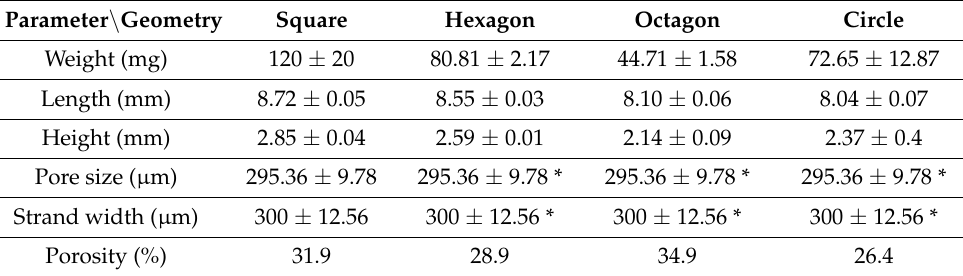
Table 3. Dimensions and weight of the PCL scaffolds with variations in outer geometry.